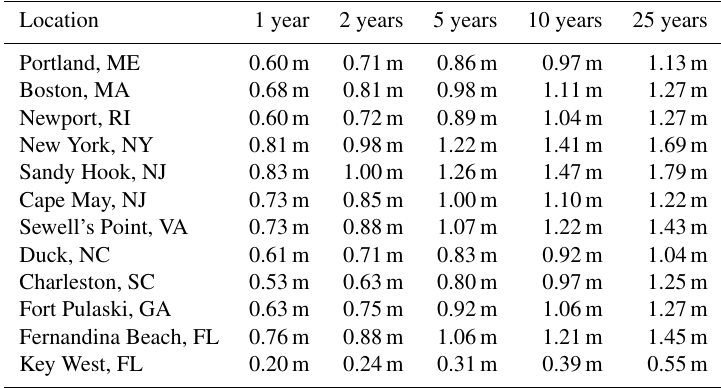
Table 3. Return levels (m) for each location for return periods of 1-, 2-, 5-, 10-, and 25-year intervals.